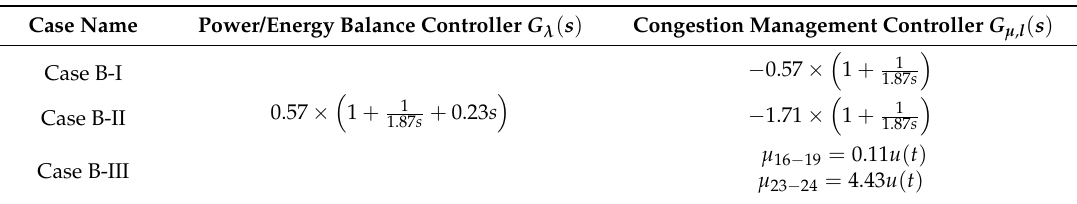
Table 4. Three designs of the power/energy balance controller in the simulation of a generation failure